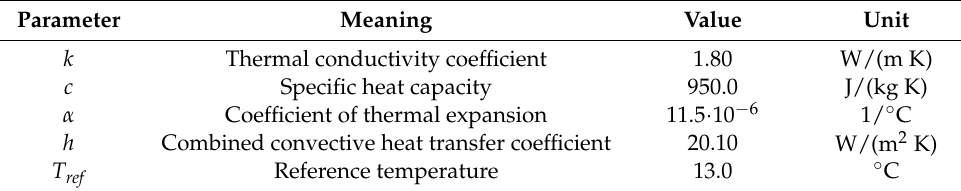
Table 4. Concrete thermal parameters.